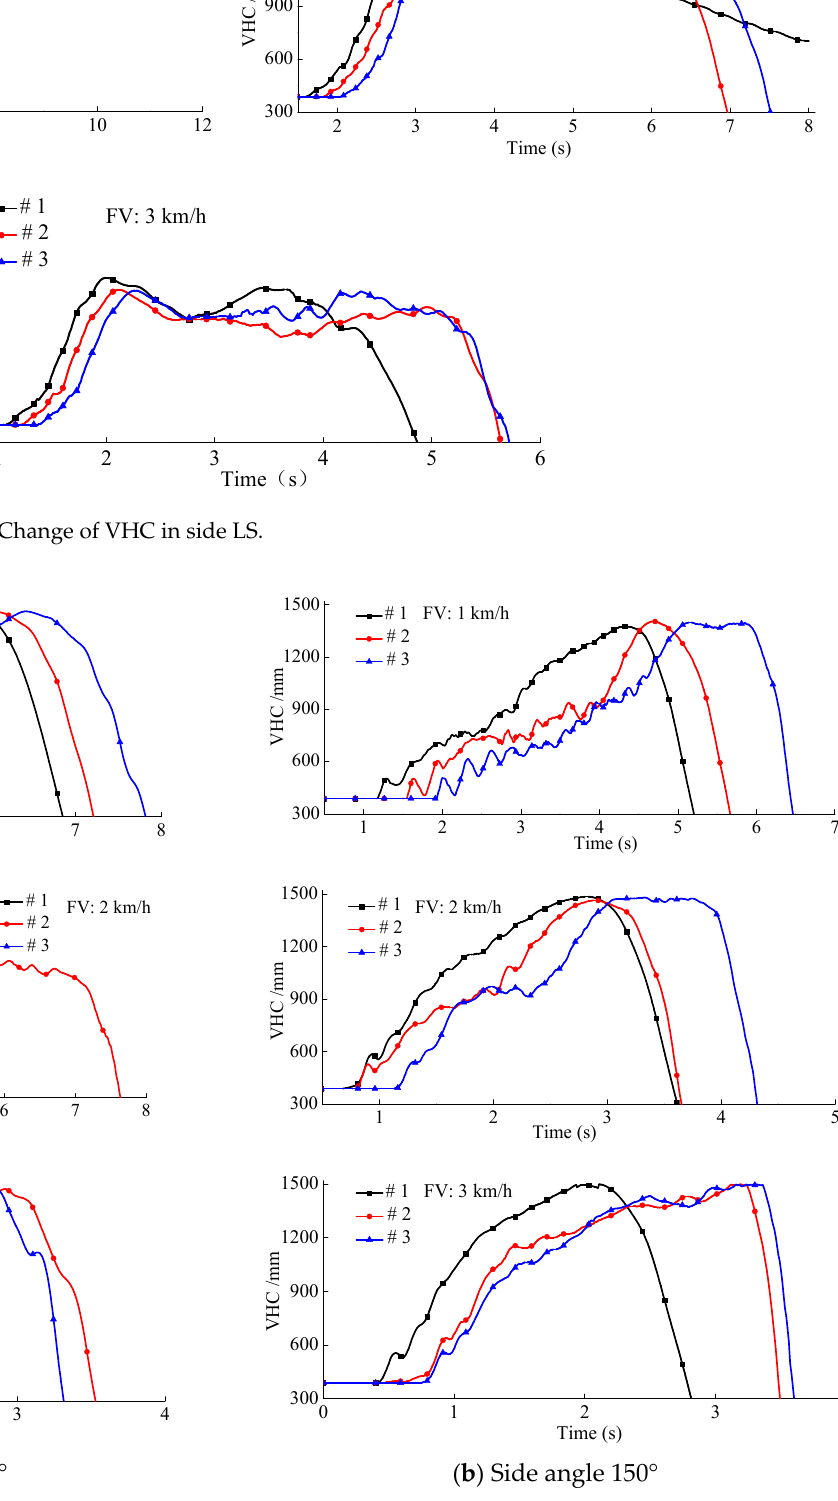
Figure 11. Change of VHC in side and inverse LS.